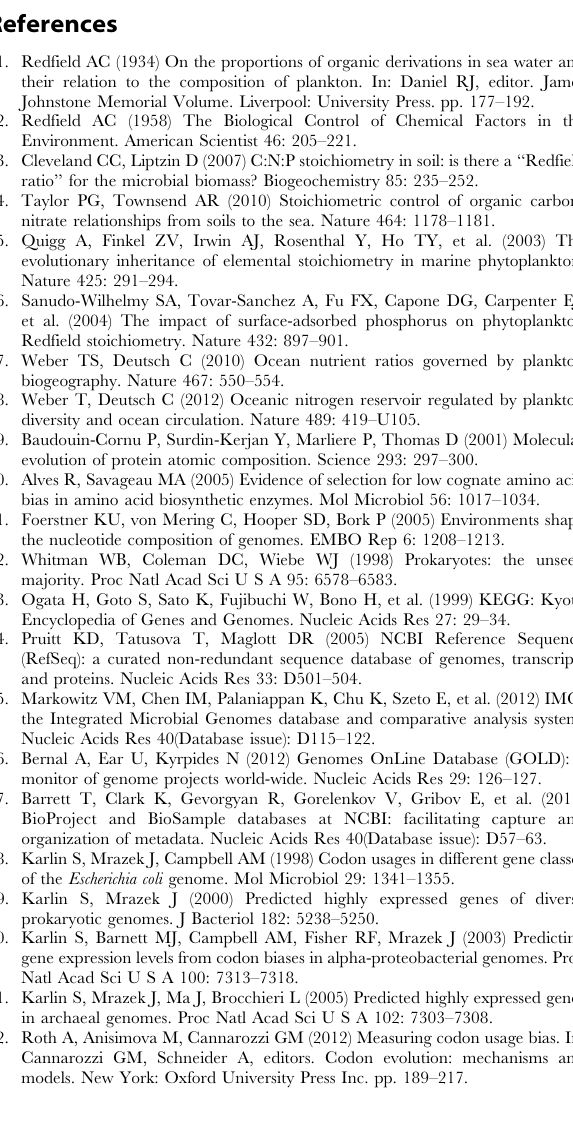
relative amino acid frequency; d aa: relative amino acid frequency weighted by d index; CAIaa: relative amino acid frequency weighted by CAI